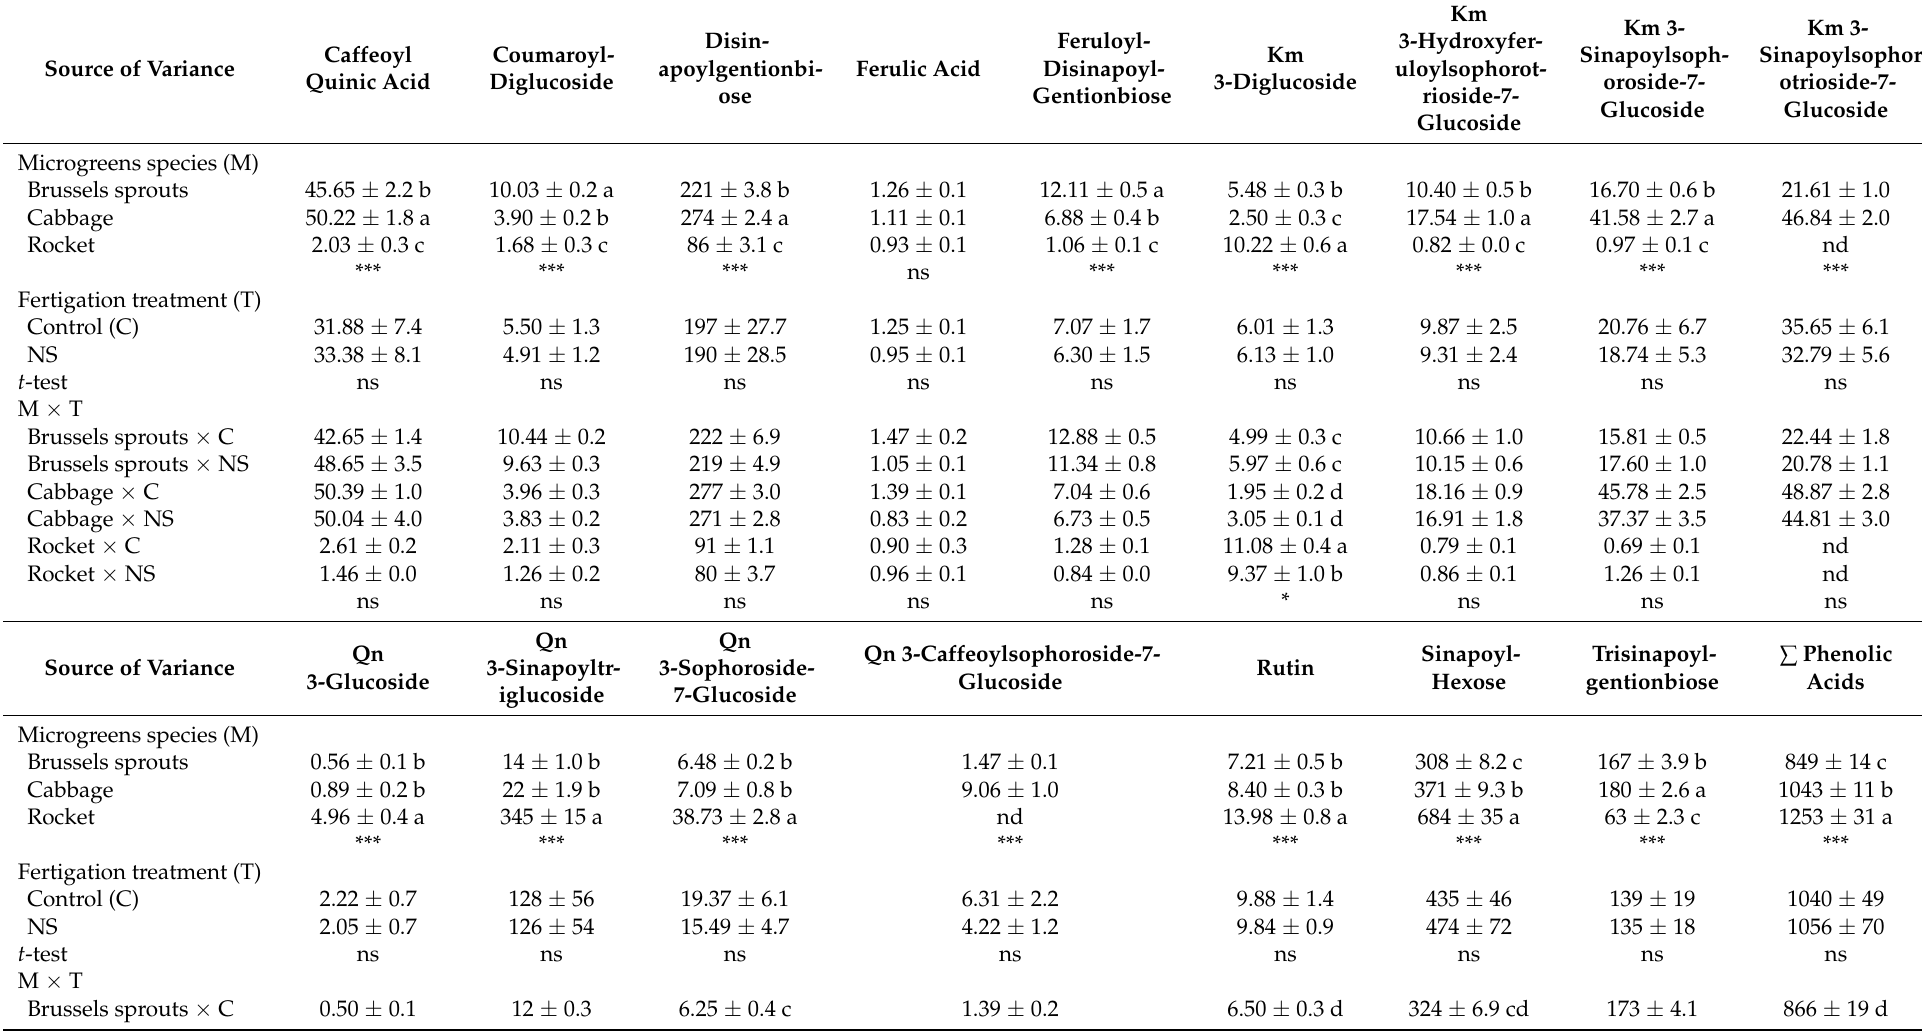
Table 4. Phenolic acids and total phenolic acids ( µ g g − 1 dw) of Brussels sprouts, cabbage and rocket microgreens in light of the nutrient solution